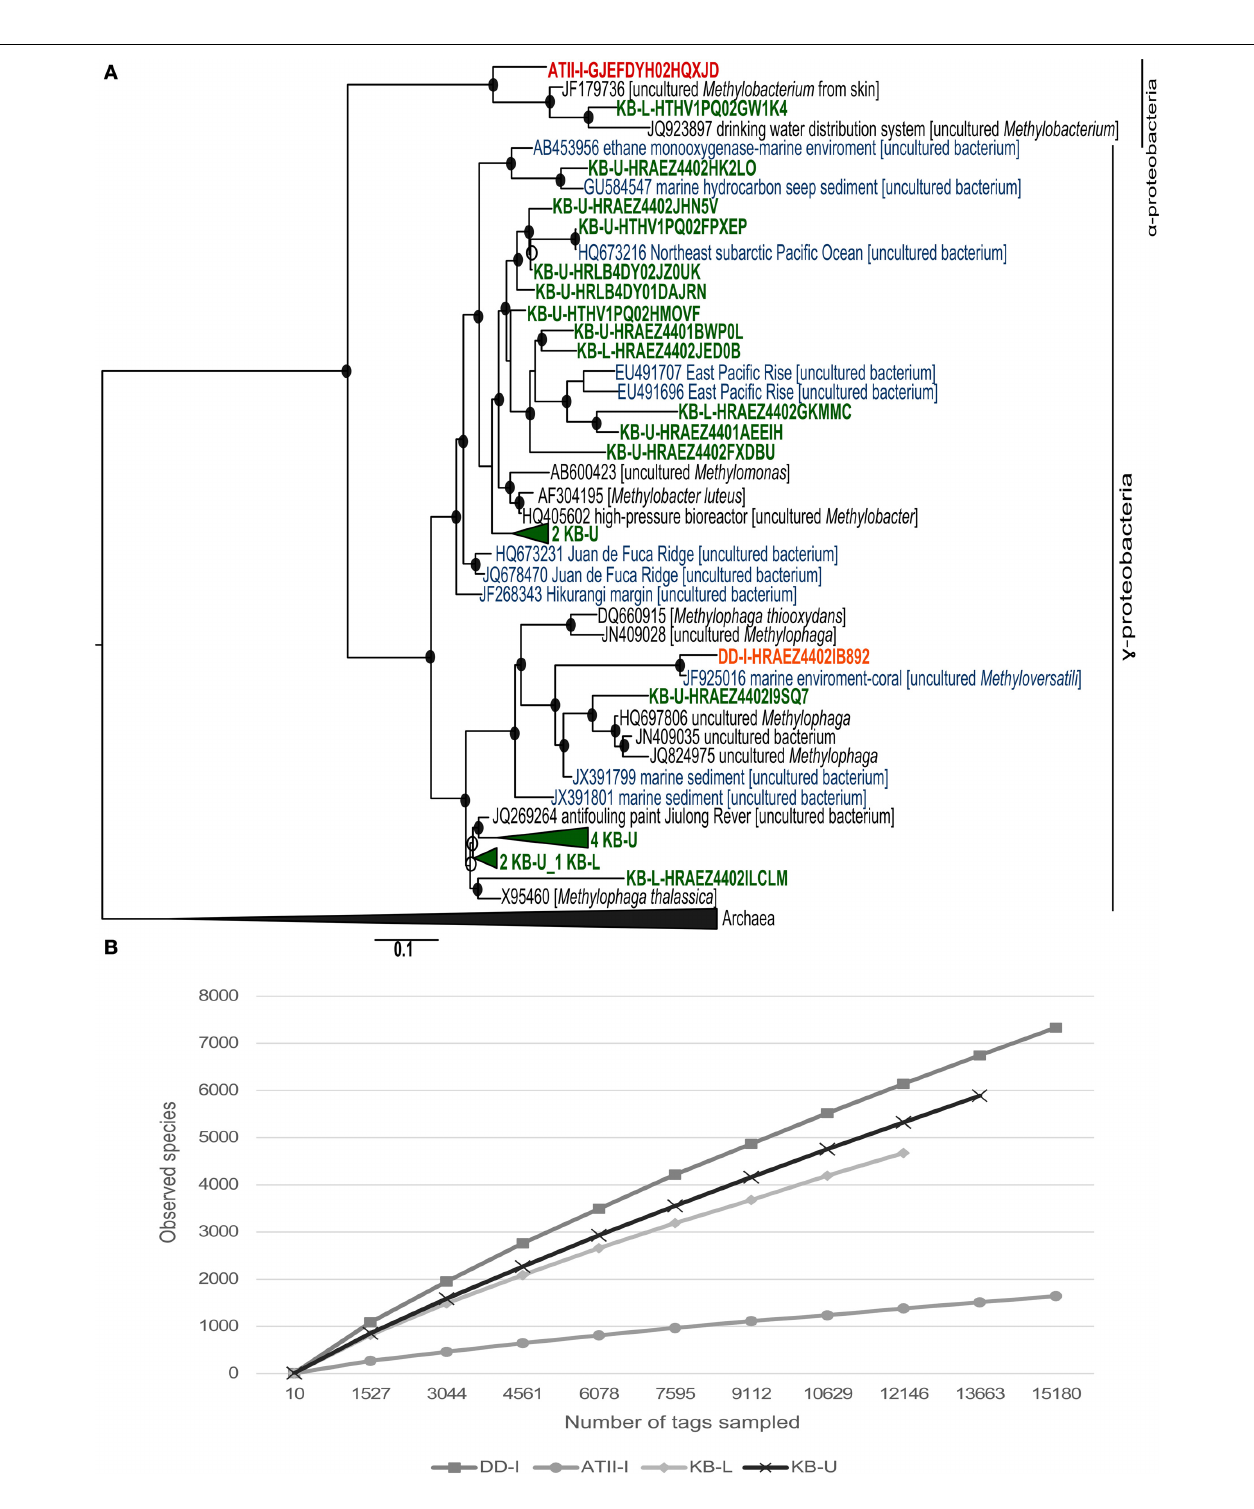
to the sample name. The trees were calculated using the maximum-likelihood approach with 100 bootstrap resampling. Bootstrap values ≥ 50% are depicted as open circles and those ≥ 70% with closed circles. The scale bar represents 10% estimated sequence divergence. (B) Species richness in the ATII-I, DD-I, KB-U and KB-L brine-seawater interface layers based on 16S rRNA pyrotag rarefaction curve analysis. Phylotypes were generated based on a distance threshold of